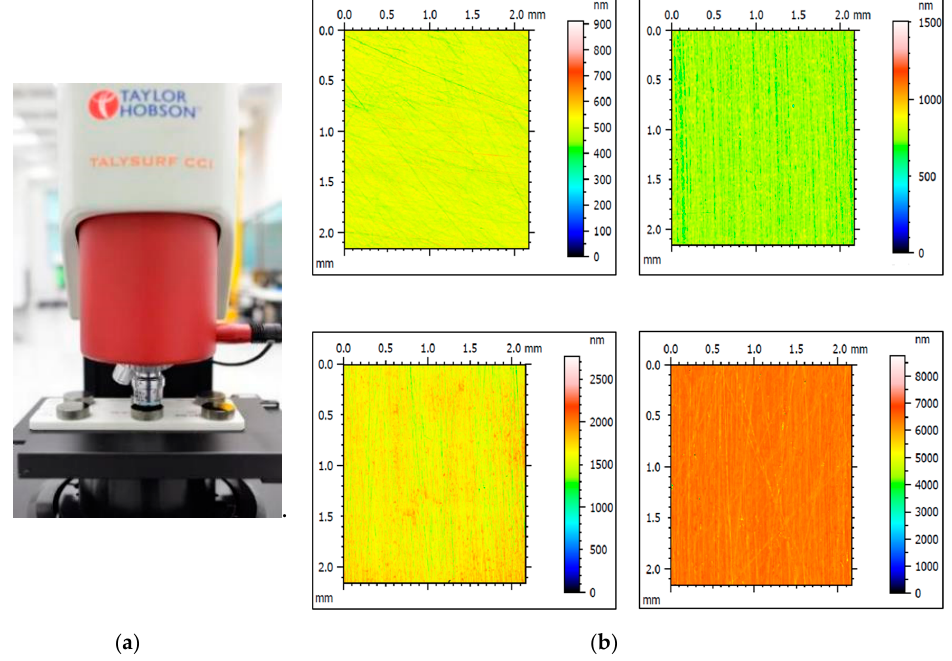
Figure 2. ( a ) Coherence scanning interferometer (Talysurf CCI HD); ( b ) Surface topography of test coupons.